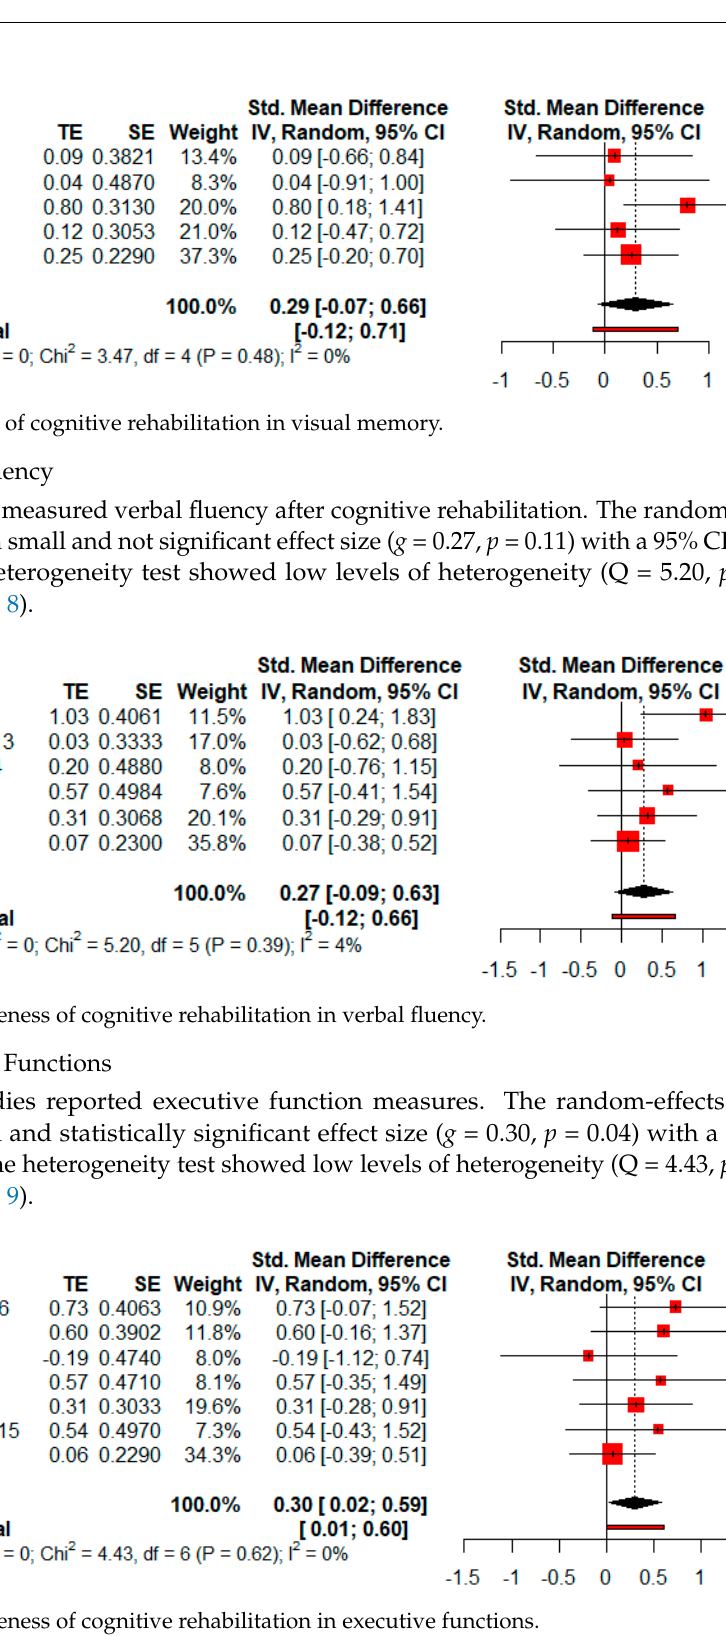
Figure 10 . Effectiveness of cognitive rehabilitation in visuospatial and visuoconstructive abilities. 3.3.10. Processing Speed Seven studies reported processing speed outcomes. The random-effects model showed a small and not significant effect size ( g = 0.24, p = 0.09) with a 95% CI ( − 0.06 to 0.54). The heterogeneity test showed low levels of heterogeneity across the studies (Q = 5.87, p = 0.44; I 2 = 0%) (Figure 11). Figure 11 . Effectiveness of cognitive rehabilitation in processing speed. 3.3.11. Others: Functionality, Depressive Symptoms and Quality of Life Functionality was only reported in two studies, and so a meta-analysis could not be performed. Seven studies evaluated depressive symptoms after cognitive rehabilitation. Depressive symptoms showed a small and not significant effect size ( g = 0.24, p = 0.08)